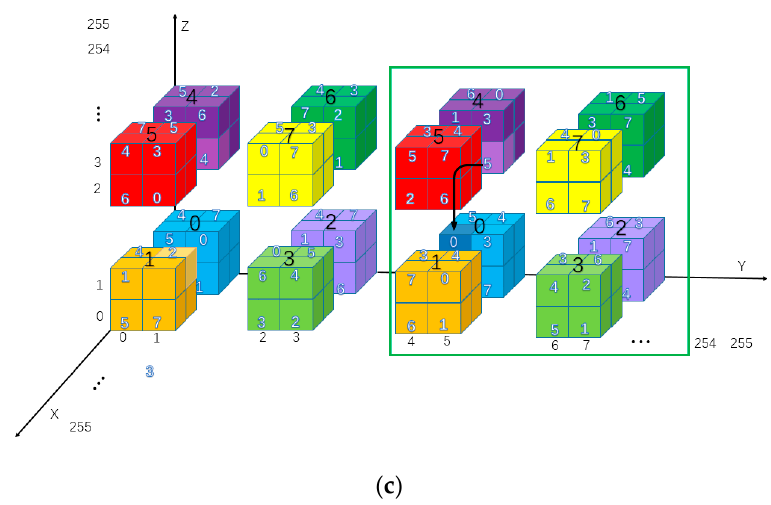
Figure 9. Examples of data hiding with cubic mini-SuDoKu matrix (CMSM). ( a ) Hide ( 001010 ) into cover triplet ( 1,1,2 ) ; ( b ) Hide ( 101010 ) into cover triplet ( 1,3,2 ) ; ( c ) Hide ( 000000 ) into cover triplet ( 1,5,2 ) .